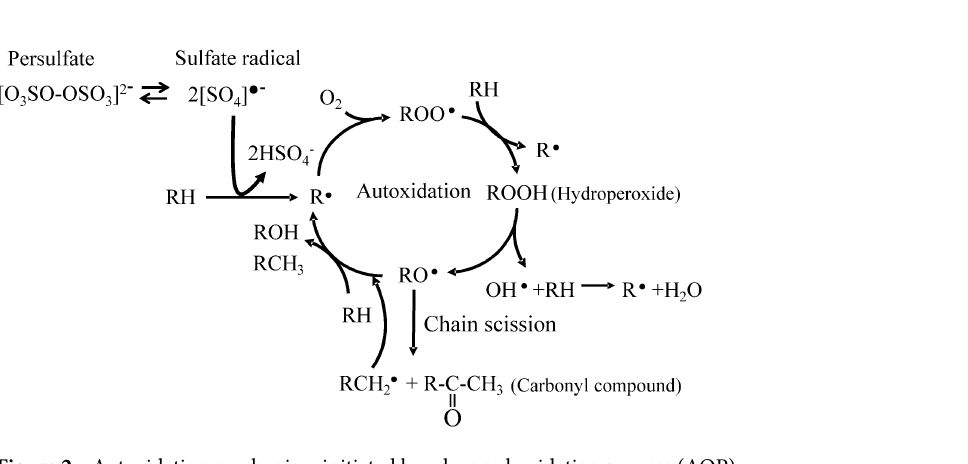
Figure 2. Autoxidation mechanism initiated by advanced oxidation process (AOP).